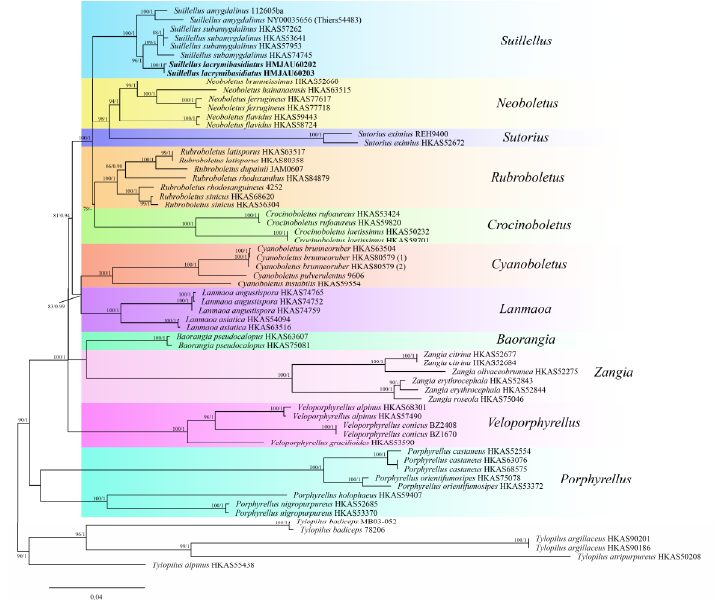
Figure 3. Phylogenetic analysis of Suillellus inferred from ML analysis based on the multi-locus dataset. BP value (>70) and PP value (>9) are shown around branches. Our new species sequences are indicated in bold.